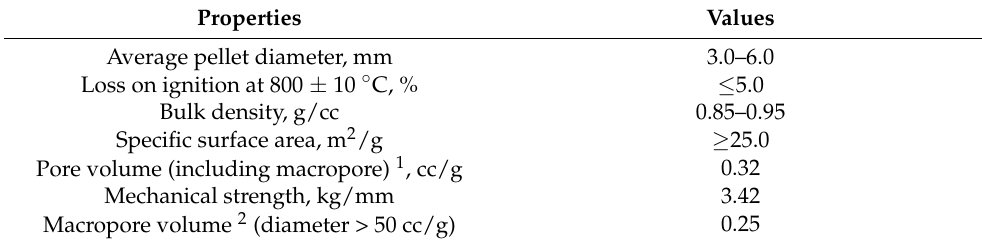
Table 1. Characteristics of adsorbent.